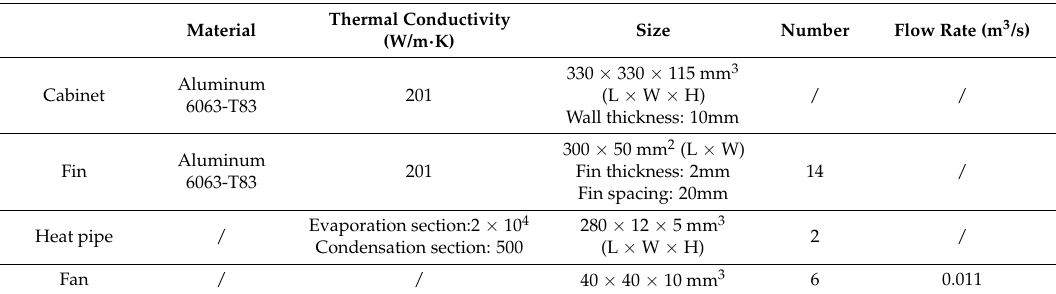
Table 2. Material properties and sizesin the finite-element model.